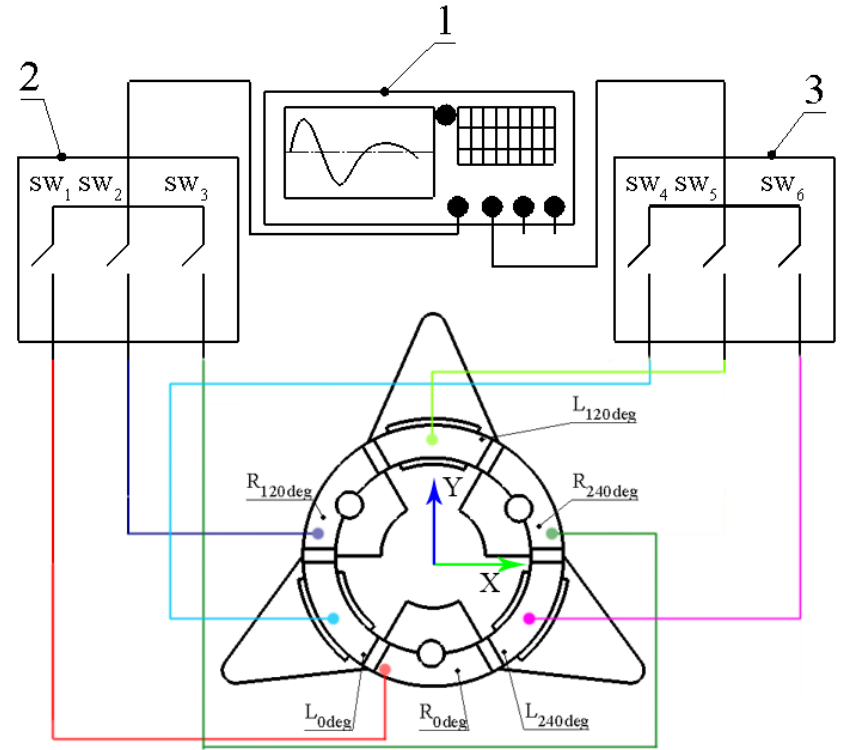
Figure 3. Excitation schematics of the robot; 1—excitation signal source with two independent channels; 2—switch box for planar motion control; 3—switch box for angular motion control. Different trajectories of robot locomotion and payload rotation can be obtained via